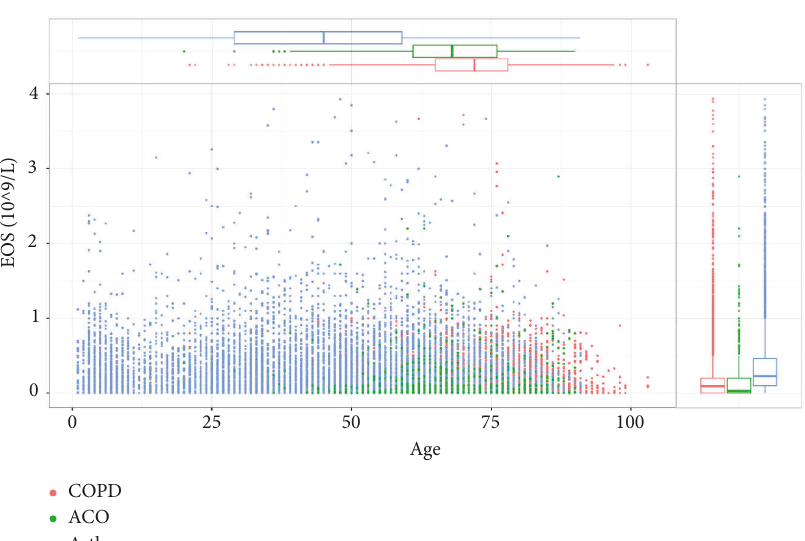
Figure 1: Distribution of eosinophils at different ages in the three diseases. (COPD, chronic obstructive pulmonary disease; ACO, asthma- COPD overlap; EOS,